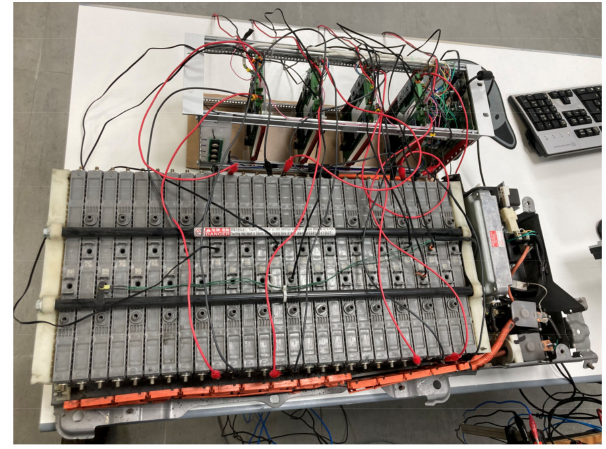
Figure 11. Toyota Prius battery and prototype connections to the battery cells.